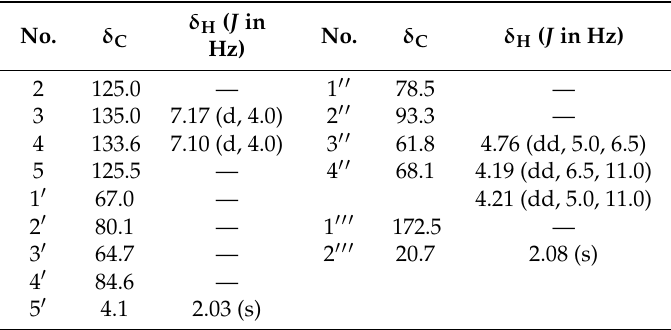
Table 2. 1 H- and 13 C-NMR data for 2 in CD 3